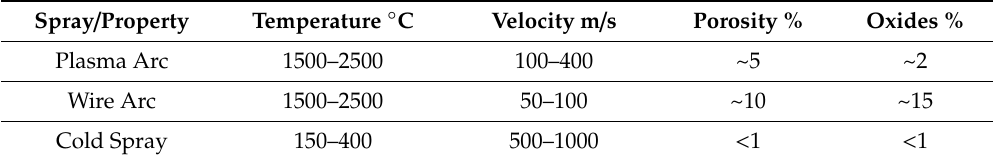
Table 1. Particle impact and deposition